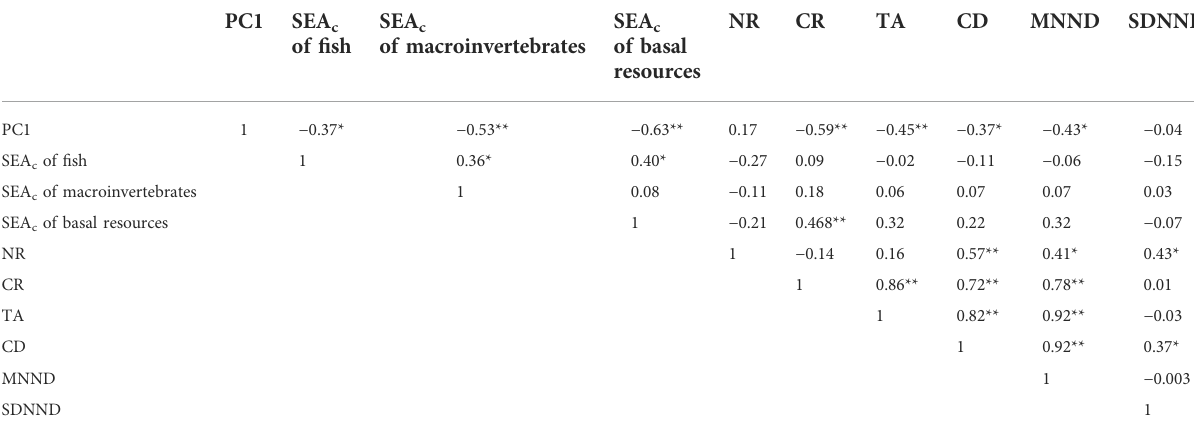
TABLE4Pearsoncorrelationcoef fi cientsbetween waterqualityparametersrepresentedbytheprincipalcomponent1(PC1)andfoodwebmetricsat woodland